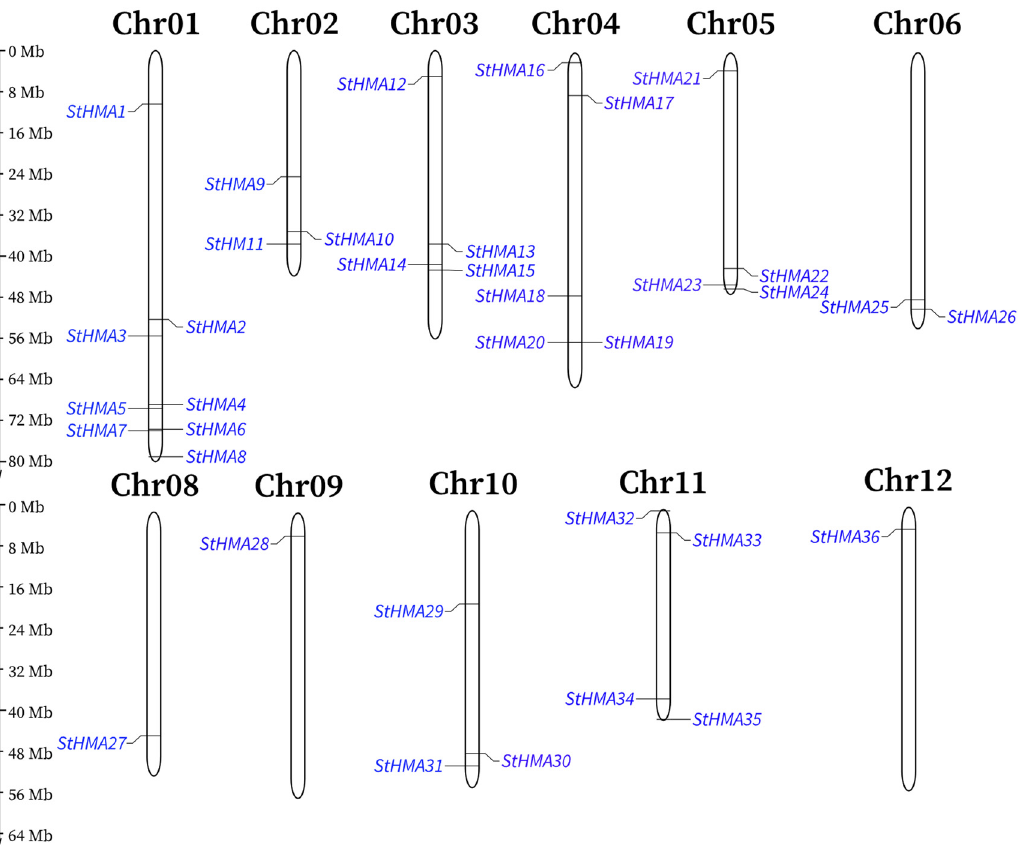
Figure 1. Chromosomal locations of StHMA genes in Solanum tuberosum . Black bars represent the chromosomes. Chromosome numbers are shown at the tops of the bar. StHMA genes are labeled at the left and right of the chromosomes. Scale bar on the left indicates the chromosome lengths (Mb).